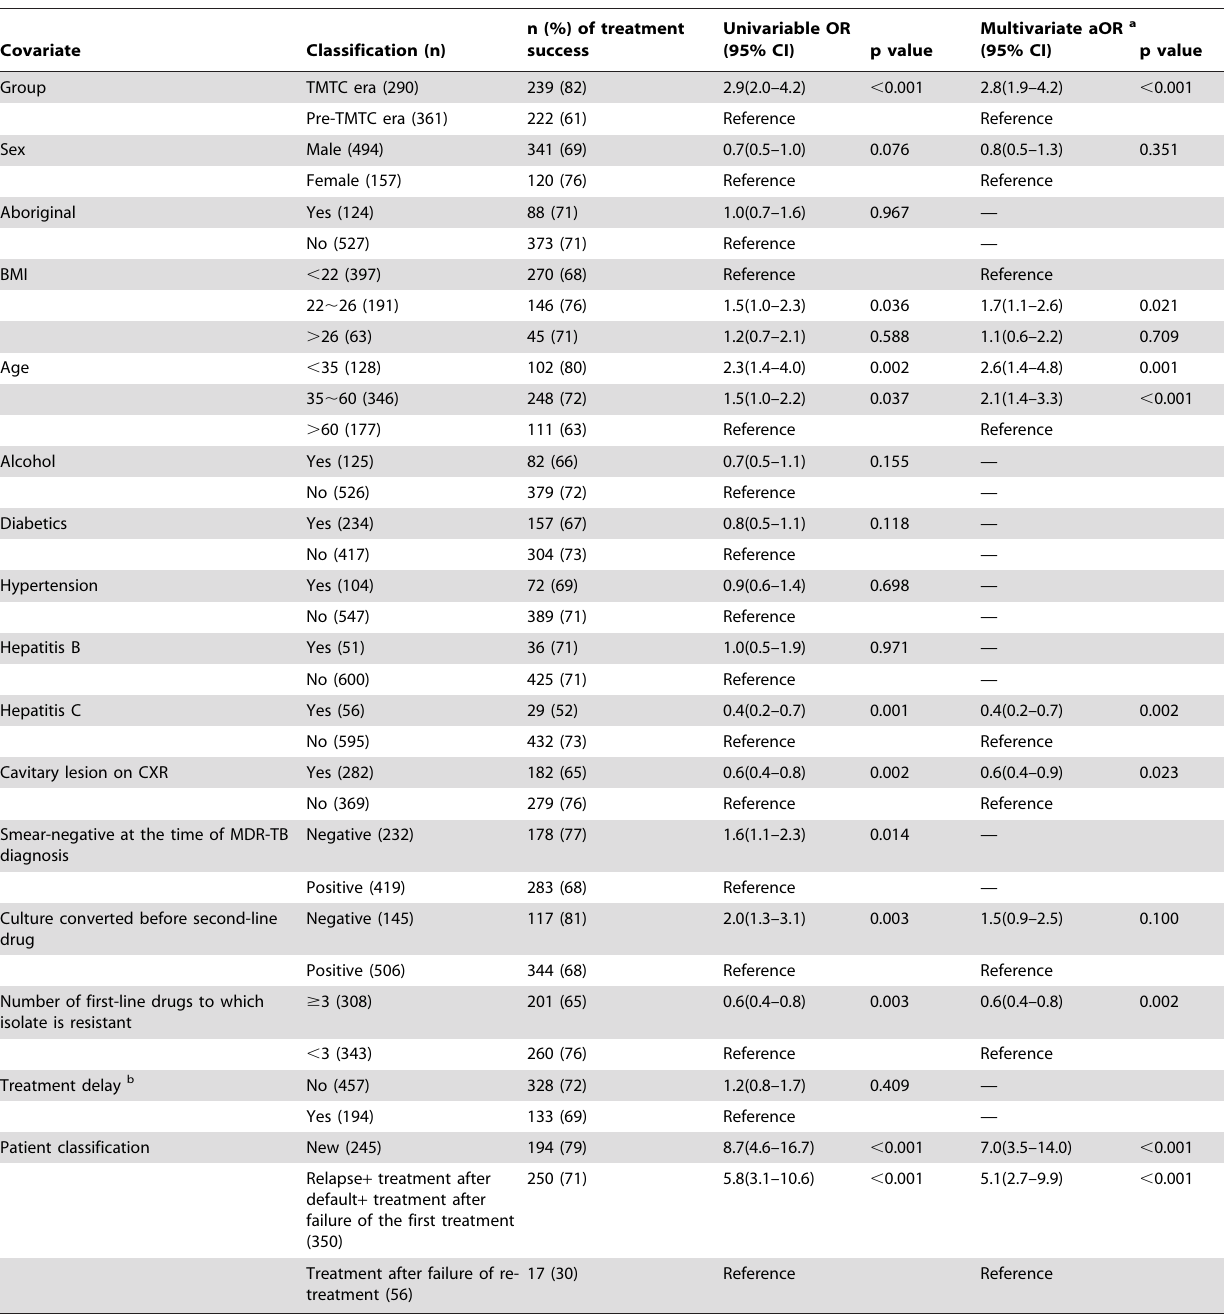
a Multiple logistic analysis, adjusted with covariates chosen by Akaike information criterion (AIC). b Treatment delay: the lag between sputum collection of MDR-TB and start of second-line drug . 120 days. Abbreviations: aOR: adjusted odds ratio; BMI: body mass index; CI: confidence interval; CXR: chest X-ray; MDR: multidrug-resistant; TB: tuberculosis; TMTC: Taiwan Multi- drug Resistance Tuberculosis